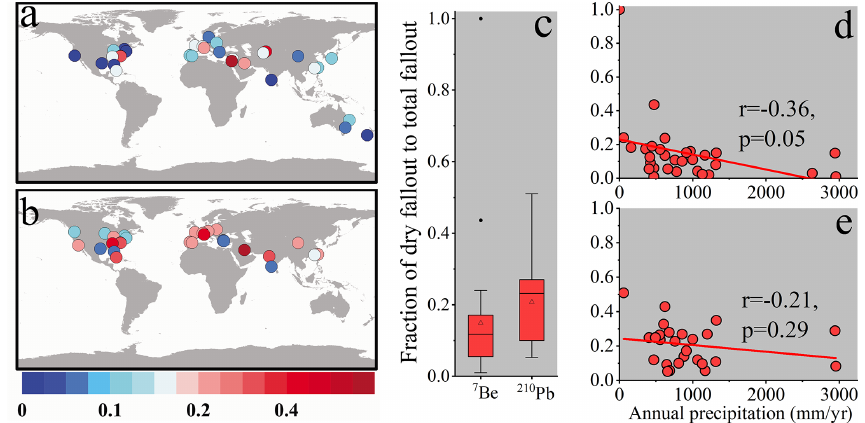
Figure 6. Global distribution of the fraction of dry to total depositional fluxes of (a) 7 Be and (b) 210 Pb. (c) Box and whisker plots showing the comparison between the fraction of dry to total depositional fluxes of 7 Be and the fraction of dry to total depositional fluxes of 210 Pb. (d) The fraction of dry to total depositional fluxes of 7 Be versus annual precipitation. (e) The fraction of dry to total depositional fluxes of 210 Pb versus annual